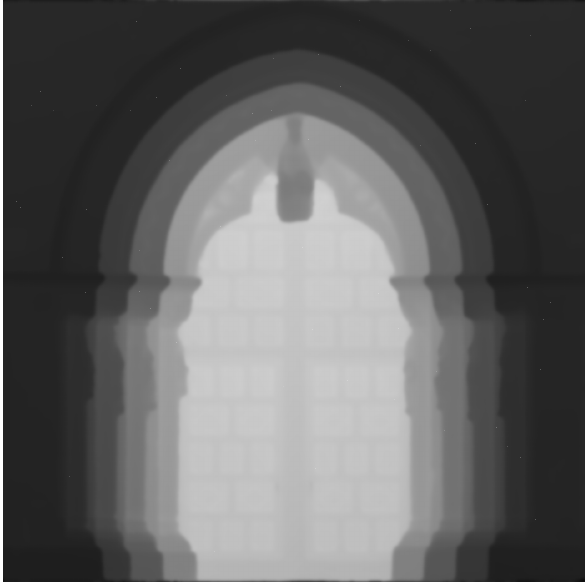
Figure 4: Depth map of the densely reconstructed model. Each pixel represents a different depth w.r.t the chosen orthogonal view plane.